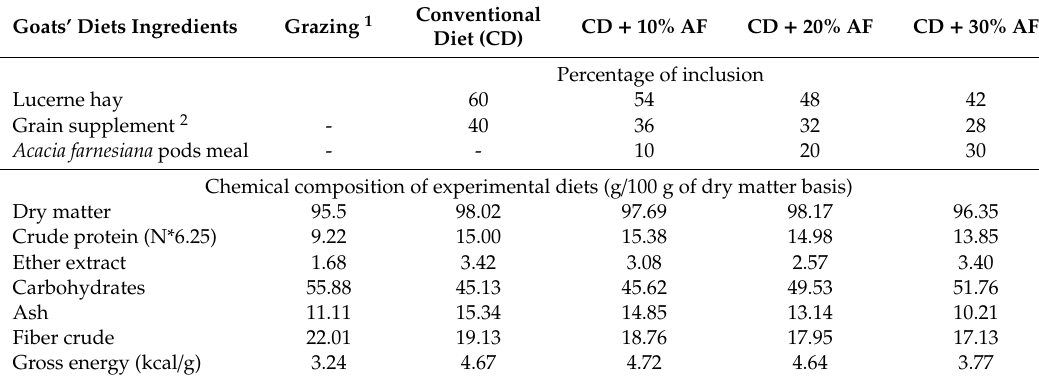
Table 1. Goats’ diets ingredients, experimental diets (g / 100 g) from semiarid systems in Mexico. Goats’ Diets